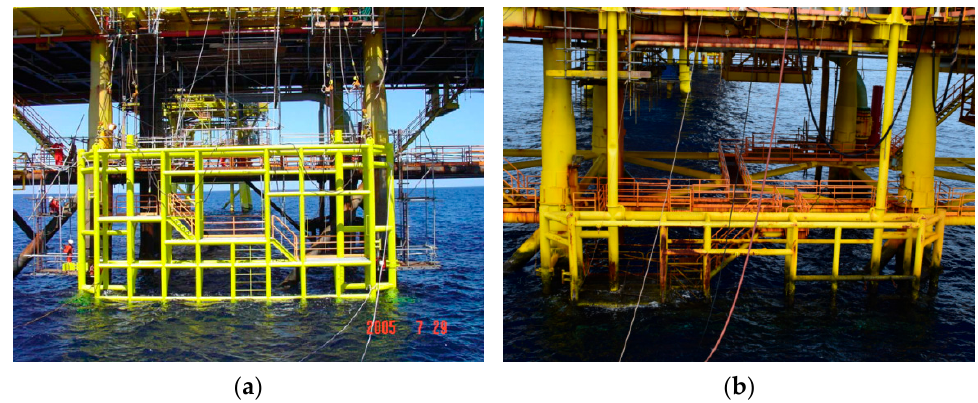
Figure 2. Evidence of platform subsidence: ( a ) photo in 2005; ( b ) photo in 2016.